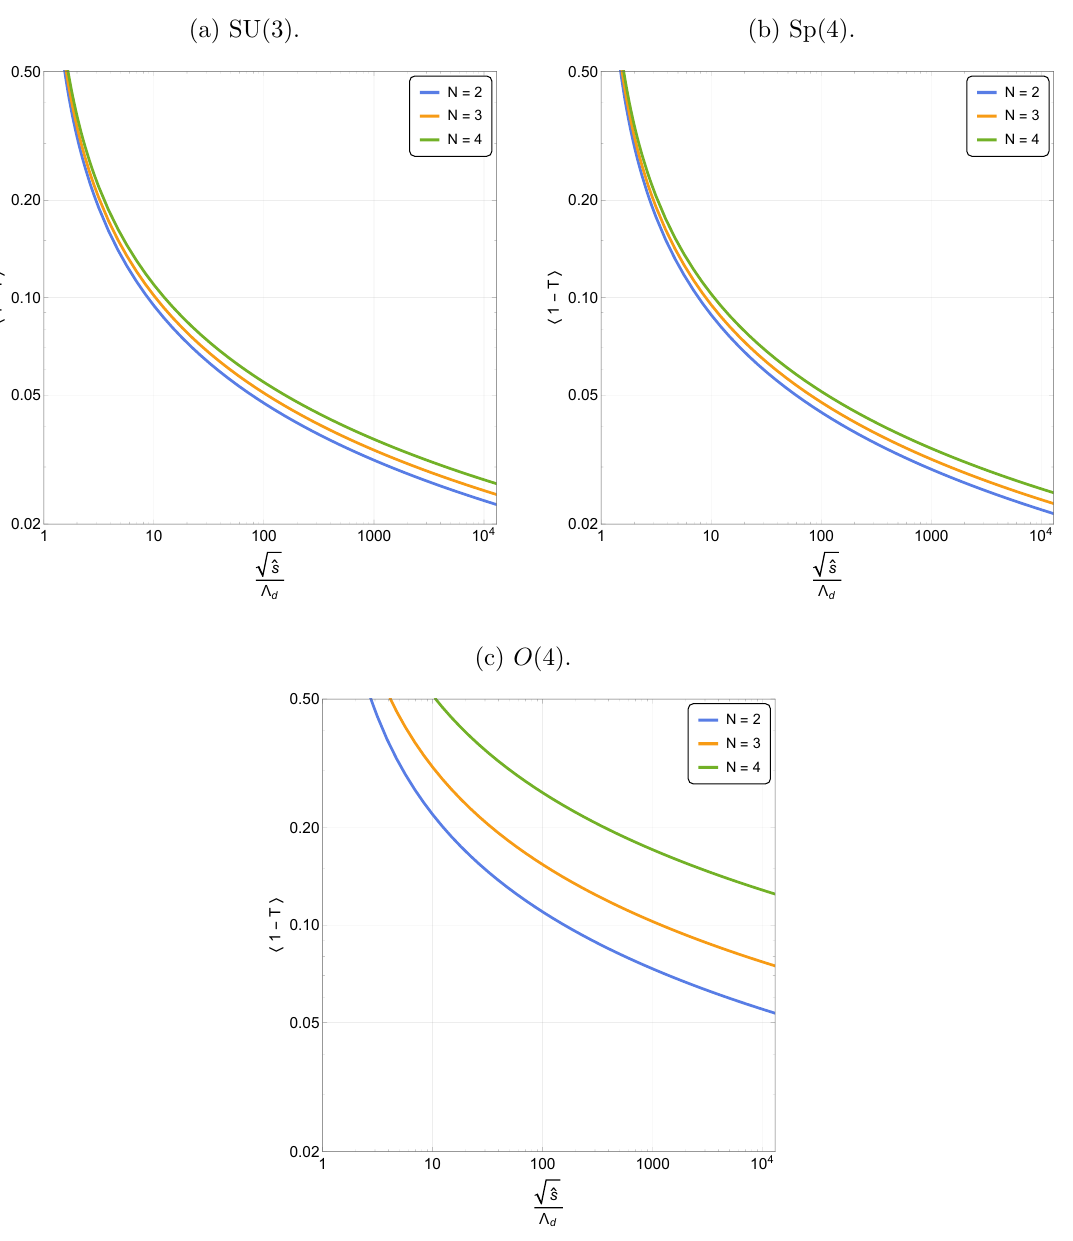
p ^ s= (cid:3) d for gauge group SU(3)